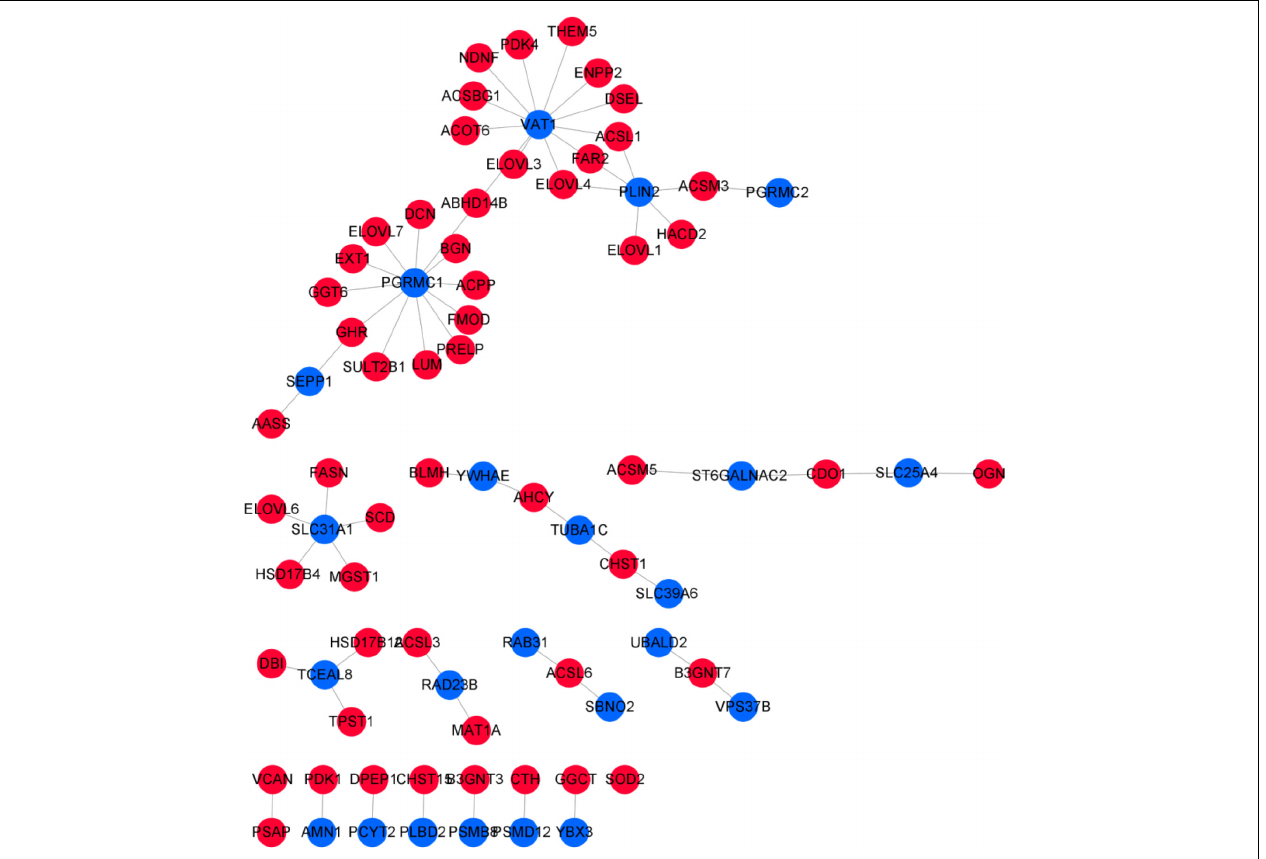
FIGURE 13 | Correlation network of sulfur metabolism genes and tissue-specific expressed genes. The blue nodes represent tissue-specific genes, and the red nodes represent sulfur metabolism